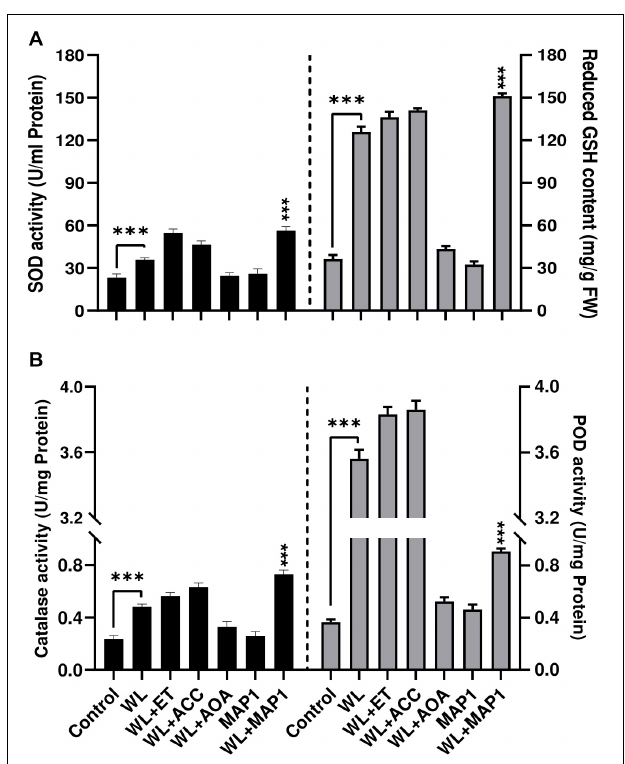
FIGURE 7 | Effect of WS on antioxidant enzyme activity (A) SOD (left-axis), reduced glutathione (GSH) contents (right-axis) (B) CAT (left-axis), POD (right-axis) in wheat plants with and without MAP1 inoculation. Quantitative data represent means ± SD of three independent experiments and at least 10 technical replicates each. The asterisks indicate a significant difference compared to untreated control ( ∗∗∗ p ≤ 0.005). TaSPDS (3.5-fold), and TaSPMS (3.6-fold) in MAP1-inoculated waterlogged wheat plants as compared to control.